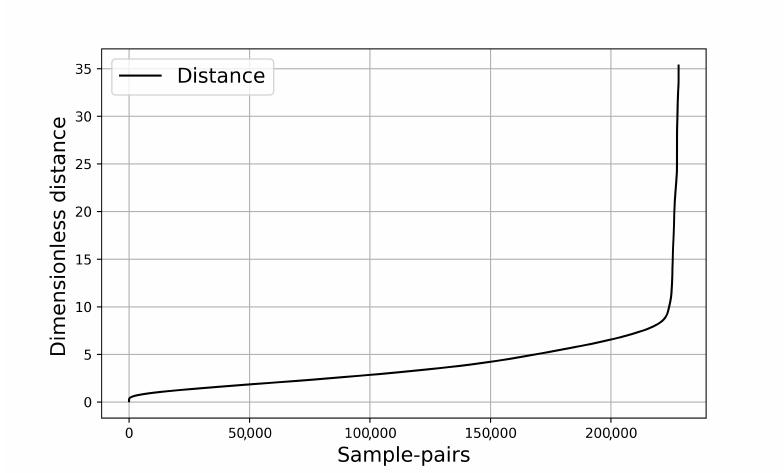
Figure 9. The distance distribution of the waves. x axis: the number of sample-pairs with less distance than y